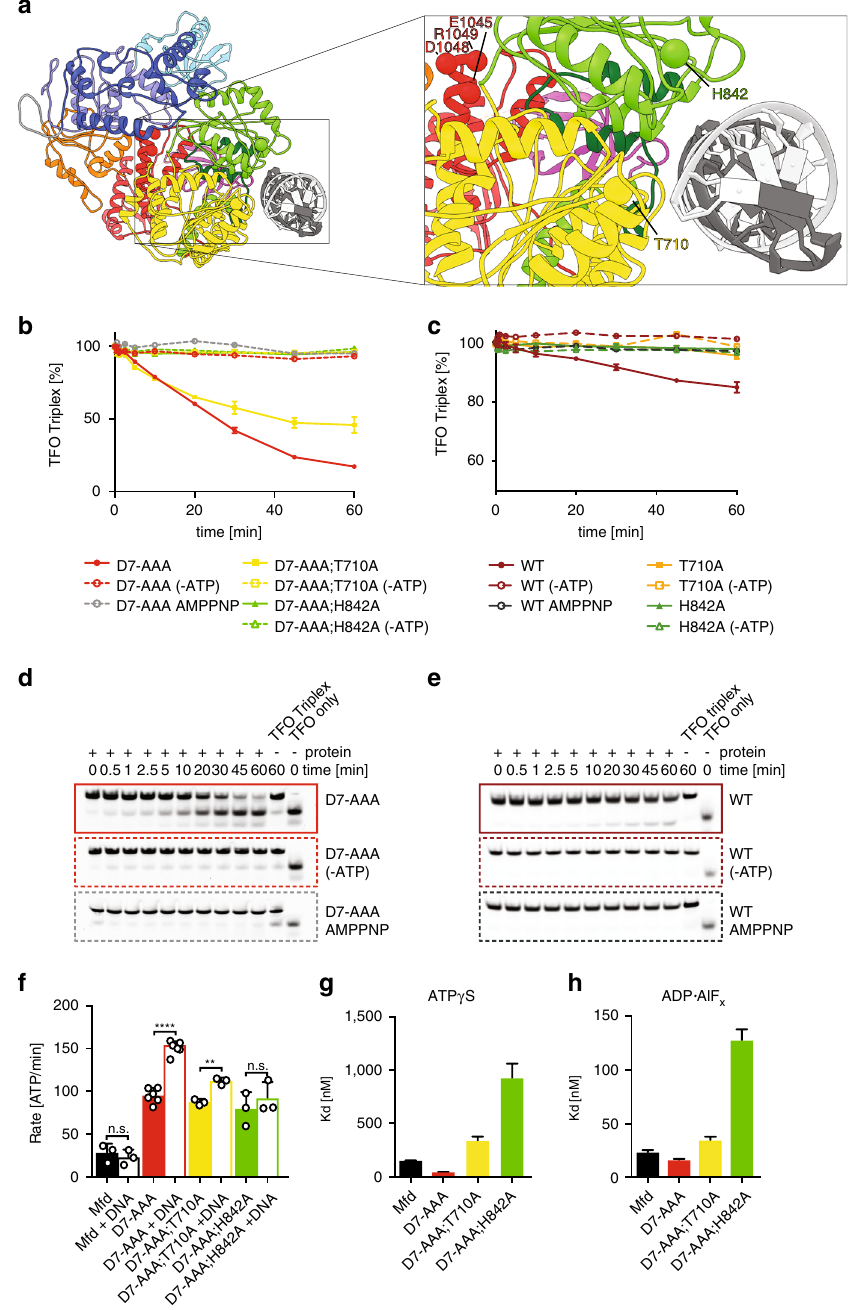
Fig. 7 T710 and H842 are critical regulators of translocation by Mfd. a EM-based model of DNA-bound Mfd with boxed region highlighting the structural environment of T710 and H842 residues. The resolution of our reconstruction precludes precise determination of the conformation of motif IVa loop and of amino-acid rotameric forms. Crucial residues are indicated as C α spheres, H842 in green, T710A in yellow and E1045, D1048, and R1049, mutated in Mfd D7 AAA in red. b – c TFO displacement assays carried out with Mfd D7 − AAA b and Mfd c variants. Percentage of remaining TFO-Triplex is plotted vs time to show translocation of Mfd variants. Plot shows means± SD ( n = 3), with error bars often smaller than symbols. d – e Electrophoretic separation of TFO displacement assays carried out with Mfd D7 − AAA . Representative gels for Mfd D7 − AAA d and Mfd e + /-ATP and + AMPPNP are shown. Example gels for Mfd, Mfd D7 − AAA;T710A and Mfd D7AAA;H842A variants are shown in Supplementary Fig. 8 ( n = 3). f Steady-state ATPase activities of Mfd variants normalized to wild-type Mfd activity. Data represent means ± SD ( n ≥ 3). **denotes p < 0.01, **** p < 0.0001 and ns, p > 0.05 (unpaired two-tailed t test). The p value for Mfd D7AAA;T710 with/without DNA was 0.0012. g , h Equilibrium dissociation constants for the Mfd-dsDNA interaction derived from fl uorescence anisotropy binding curves obtained by titrating increasing amounts of protein into a mixture of 10 n M HEX-labeled 40mer DNA and 2.0 m M ATP γ S e and ADP • AlF x . Data represent mean values ± SD ( n = 3). K D values are tabulated in Supplementary Table 1. Source data are provided as a Source Data fi